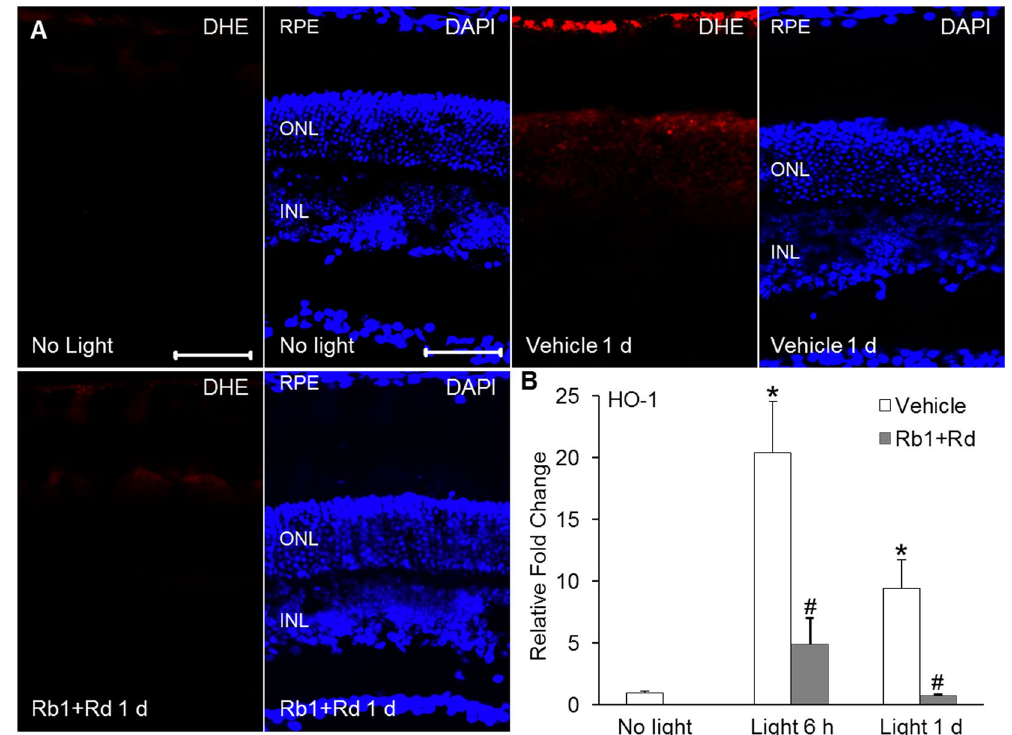
Figure 4. Combination of Rb1 and Rd alleviated retinal oxidative stress in bright light-exposed mice. ( A ) Retinal ROS production was examined by administering DHE to BALB/c mice unexposed to bright light (No light) and bright light-exposed mice treated with vehicle (Vehicle) or combination of Rb1 (65 mg/kg bw) and Rd (22.5 mg/kg bw) (Rb1 + Rb) (n = 4 per group). Cryosections were made from eye cups collected 1 d after illumination. ROS signals reflecting oxidized DHE (in red) and DAPI staining (in blue) were observed using a fluorescence microscope. INL, inner nuclear layer; ONL, outer nuclear layer; RPE, retinal pigment epithelium. Scale bar: 50 μ m. ( B ) Retinas were isolated from vehicle-treated mice unexposed to bright light (No light) and bright light-exposed mice with the indicate treatment 6 h (Light 6 h) and 1 d (Light 1 d) after bright light exposure. Total RNA was isolated and reverse-transcribed, followed by real-time PCR analyses of the expression of HO-1 (n = 4–6 per group). Relative fold change against that from the mice unexposed to bright light (No light) was presented. The data were expressed as the mean ± S.E.M. * Compared to that from No light, p < 0.05; # compared to that from Vehicle, p <